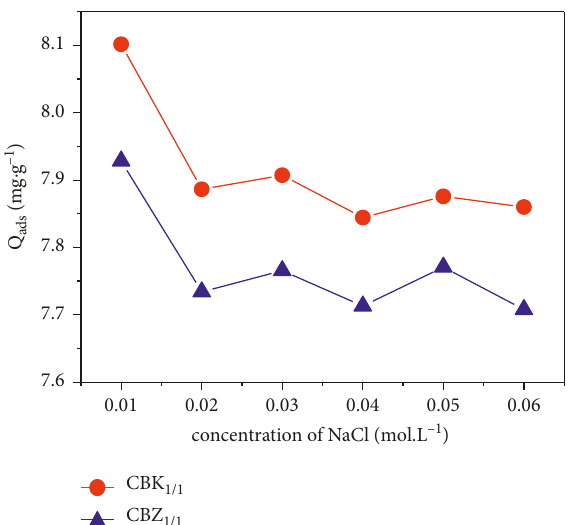
� 50mg · L − 1 ; m � 100mg; V � 20mL; 0